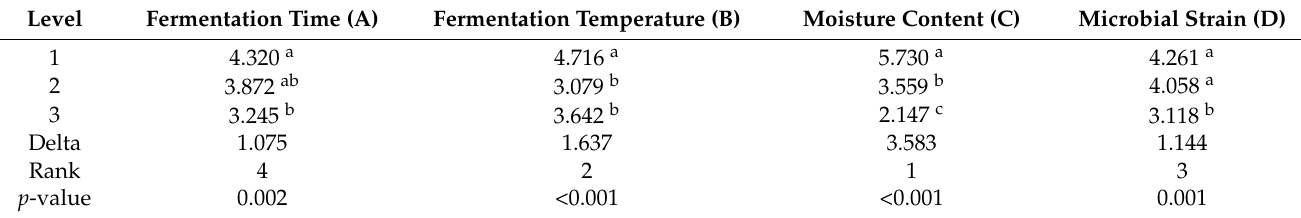
Table 8. Effects of different factor levels on glucosinolate of TMR with